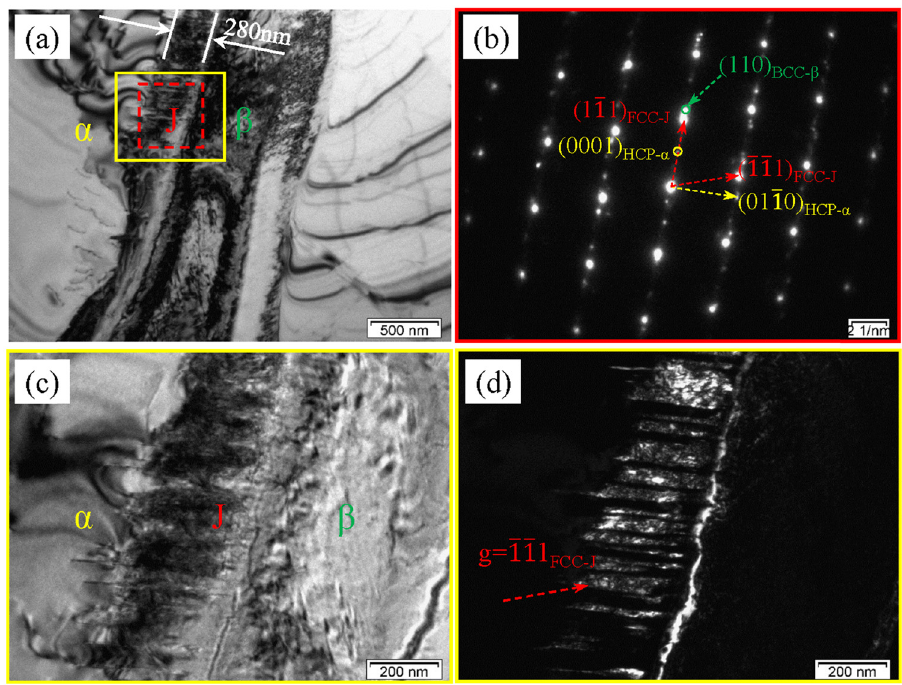
Figure 3: TEM micrographs of forged Ti80 alloy: ( a ) bright - fi eld image, ( b ) selected area electron di ff raction ( SAED ) in the red rectangle of ( c ) , ( c ) partial magni fi cation images of yellow rectangle of ( c ) , and ( d ) the dark fi eld image of ( c )